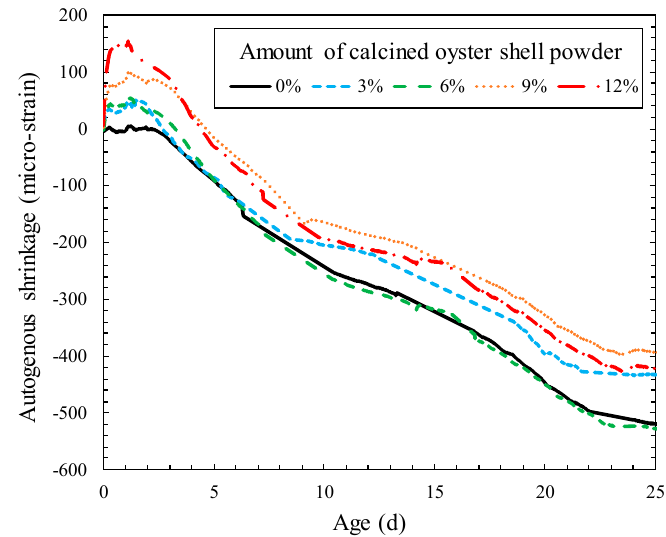
Figure 7. Effect of calcined oyster shell powder addition on autogenous shrinkage of cement mortar.